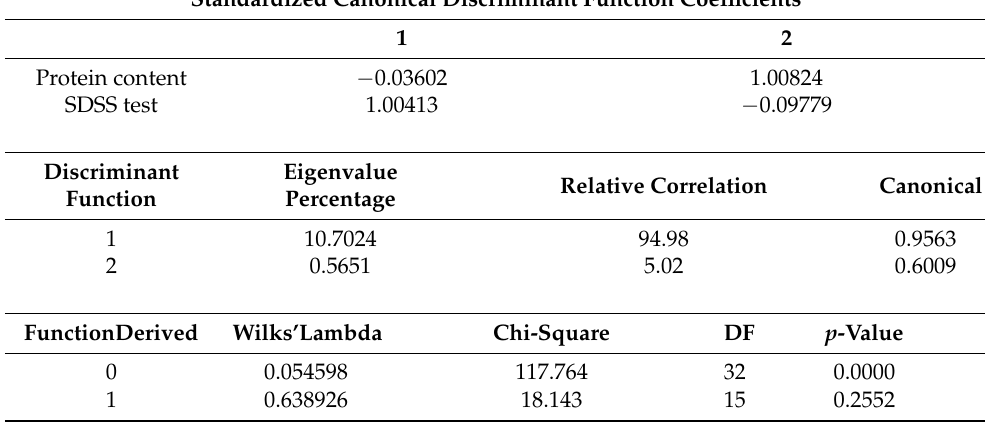
Table 4. Discriminant function analysis of durum wheat genotypesconsidering different HMWGS and LMWGS genotypes as groups.